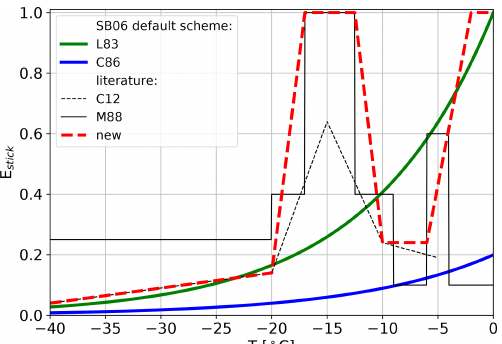
Figure 4. The sticking efficiency ( E stick ) in the SB06 scheme for collisions among ice particles (ice self-collection) follows L83; for other collisions (ice–snow collection, snow self-collection) it ap- plies the C86 parameterization. Our new relation (red) combines the relations from M88 and C12 with a characteristic maximum around − 15 ◦ C and values quickly approaching unity for temperature larger than − 5 ◦